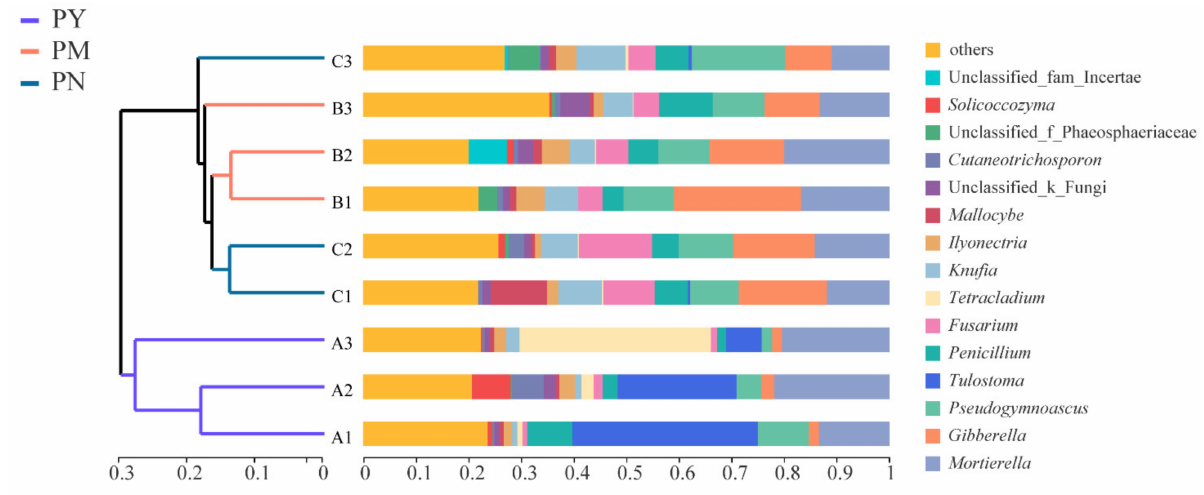
Figure 7. Hierarchical clustering analysis of the composition of rhizosphere soil fungal community of P. tabuliformis at different stand ages. PY: young forest (10a), PM: middle-aged forest (20a), and PN: near-mature forest